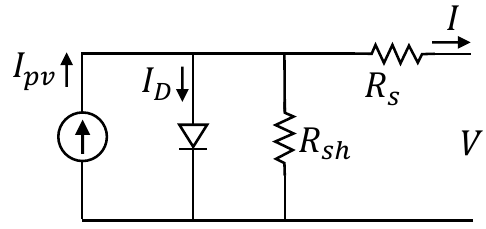
Figure 2. Circuit model of a solar